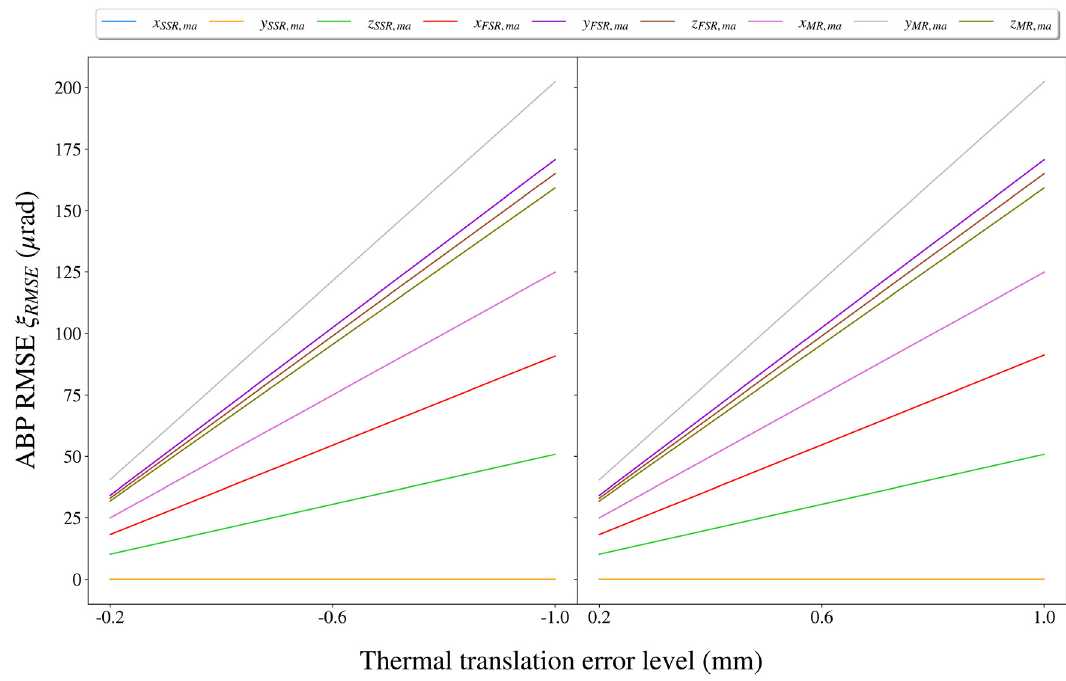
Figure 10. The impacts of different thermal translation errors at different levels on the BPE. The impact was measured by the RMSE of the ABPs over a scan period of the ECF. Table 3. The maximum impact of each thermal translation error on the BPE at the level of ± 1.0 mm. Thermal Translation